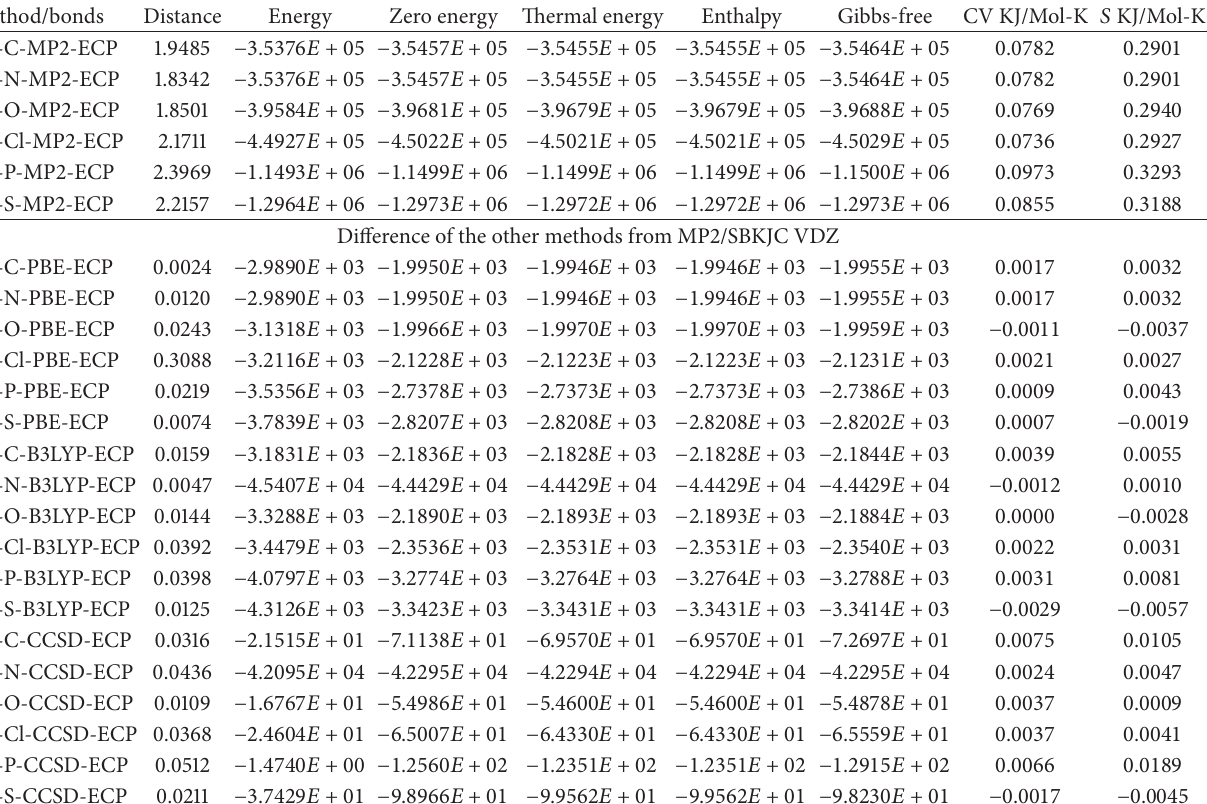
Table 2: The bond distances and thermodynamic properties using MP2/ECP method and the differences using other methods (energies in